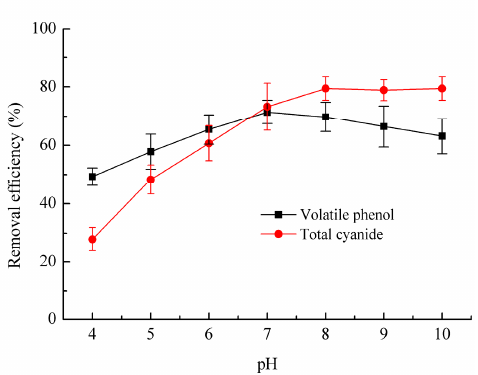
Figure 4. Effects of initial pH on the removal efficiencies of volatile phenol and total cyanide. Error Figure 4. E ff ects of initial pH on the removal e ffi ciencies of volatile phenol and total cyanide. Error bars represent the range of data from duplicate experiments. bars represent the range of data from duplicate